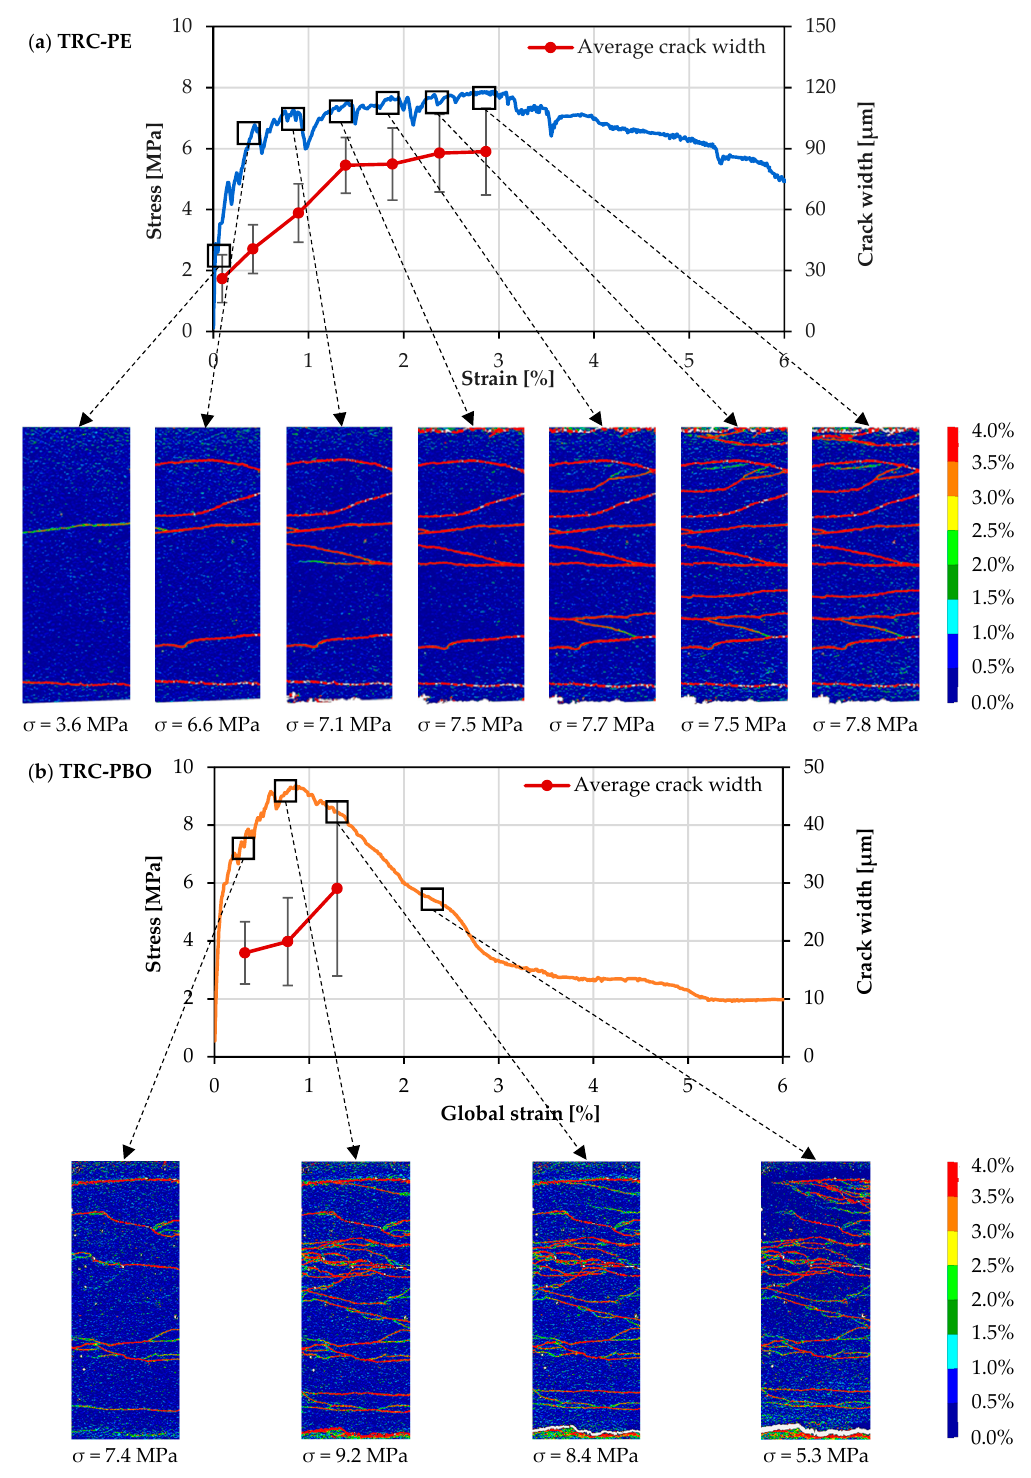
Figure 8. Tensile stress–strain curve and corresponding average crack widths of a representative specimen of both ( a ) TRC-PE and ( b ) TRC-PBO with corresponding composite stresses and crack patterns under quasi-static loading.